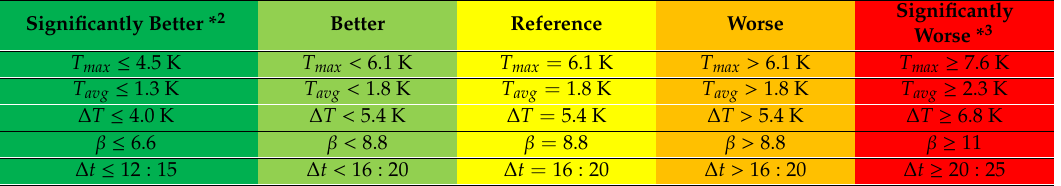
Significantly Worse * 3